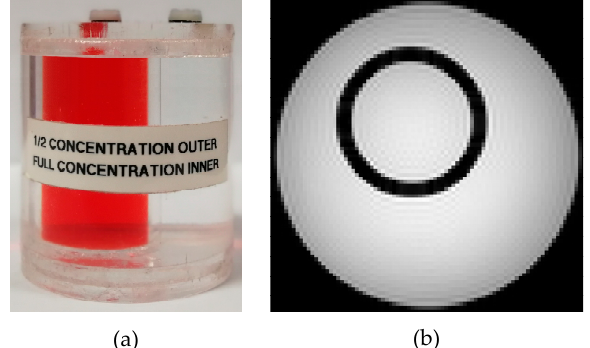
Figure 3. ( a ) The photo of the phantom used in the experiment and ( b ) the MR image obtained at 9.4 Tesla (T).